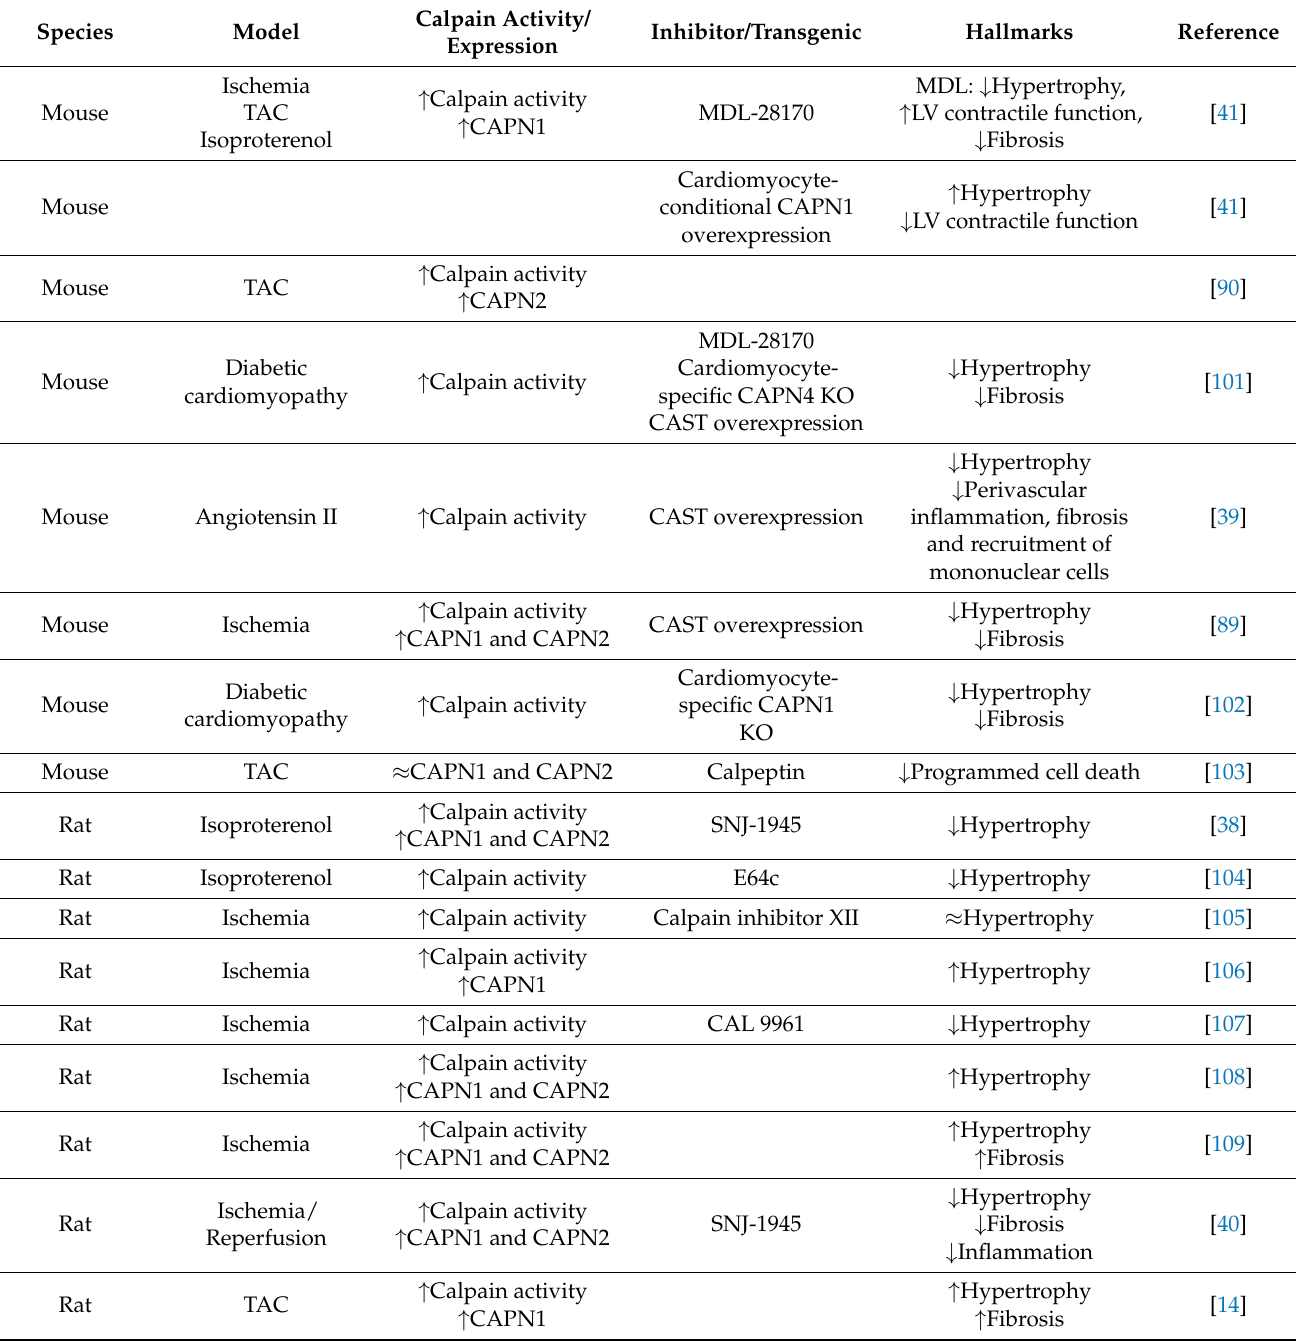
Table 1. Selected studies suggesting the calpain contribution to cardiac hypertrophy in different preclinical models of chronic stress and in patients with heart